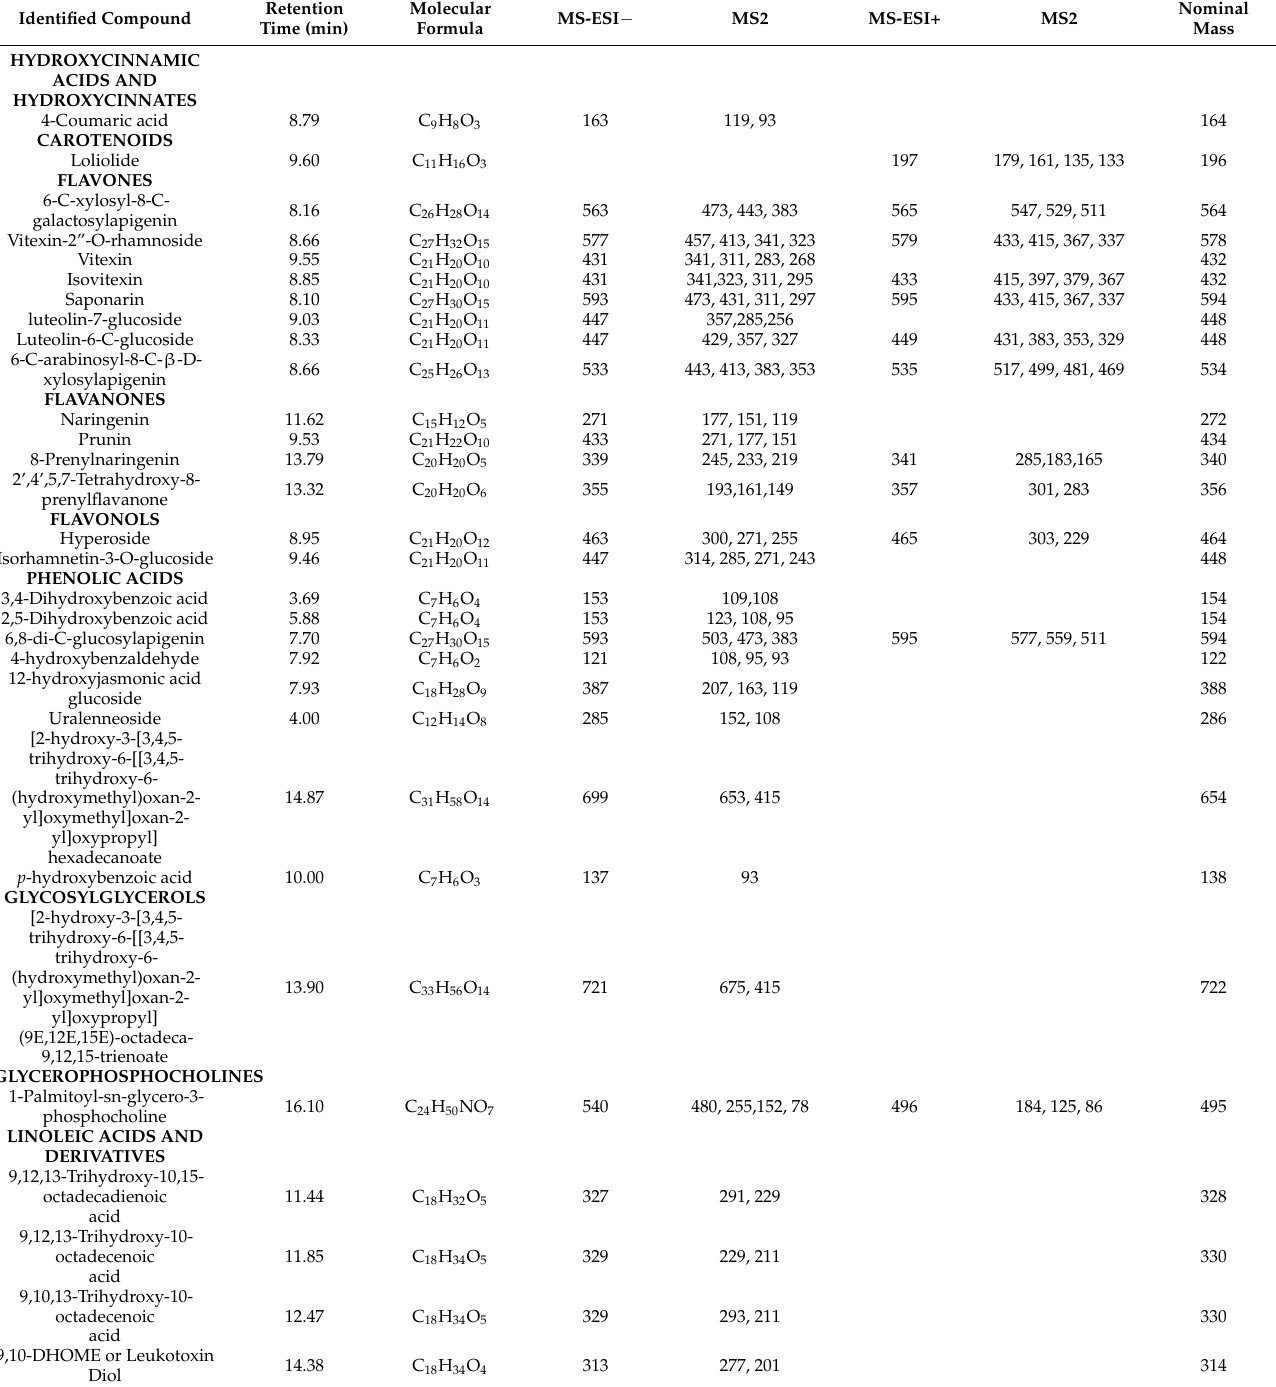
Table 1. Identification of bioactive compounds detected by UHPLC/MS in the D. tortuosum